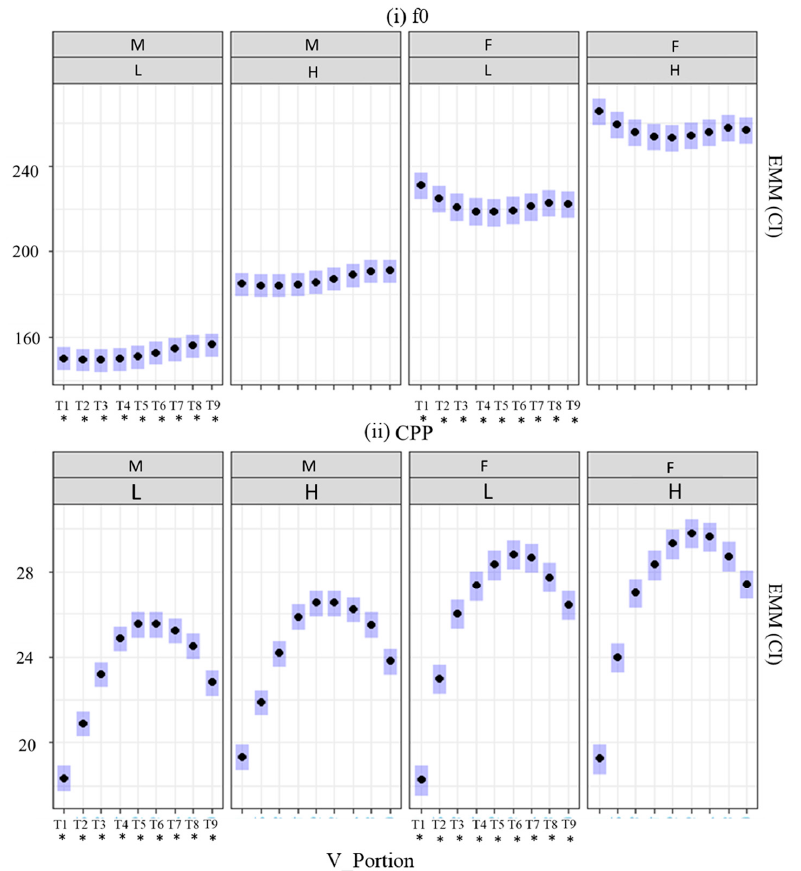
Figure 7. EMMs and confidence intervals (blue bars) of the nine timepoints of the vowels carrying contrastive tones (viz., low and high, indicated as L and H) derived from ( i ) f0 and ( ii ) CPP for male (M) and female (F) speakers separately. The asterisk (*) at each timepoint indicates the significance level of pairwise comparisons between the timepoint.